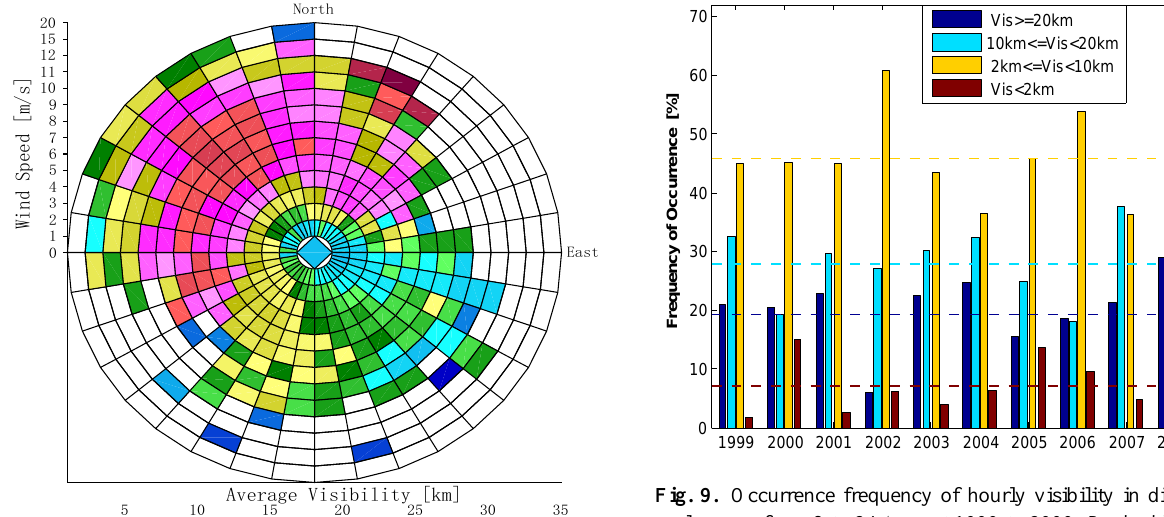
Fig. 9. Occurrence frequency of hourly visibility in different vi- sual ranges from 8 to 24 August 1999 to 2009. Dashed lines show the average frequency of visibility from 8 to 24 August in different visual ranges from 1999 to